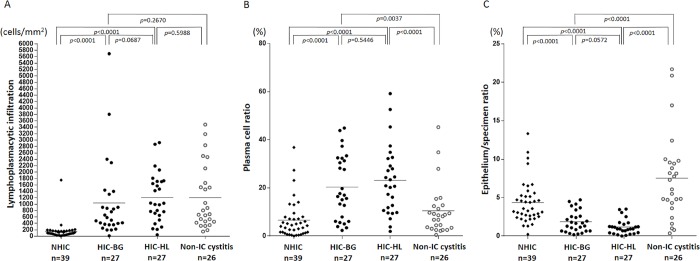
Evaluation of inflammatory cell infiltration and residual epithelium by image analysis software.(A) Lymphoplasmacytic infiltration in non-Hunner-type interstitial cystitis (NHIC), HIC-BG (background mucosa), HIC-HL (Hunner lesion) and non-IC cystitis specimens. Lateral bars indicate the means. Lymphoplasmacytic infiltration was much more severe in HIC-BG and HIC-HL than NHIC. The number of infiltrating mononuclear cells in NHIC specimens was very few (<200 cells/mm2) in most cases. The non-IC cystitis group showed a similar degree of mononuclear cell inflammation to that of HIC-BG and HIC-HL. (B) Plasma cell ratio in NHIC, HIC-BG, HIC-HL and non-IC cystitis specimens. This was significantly higher in HIC-HL and HIC-BG than in NHIC and non-IC cystitis. (C) Epithelium/specimen ratio in NHIC, HIC-BG, HIC-HL and non-IC cystitis specimens. Lateral bars indicate the means. The epithelium/specimen ratio is significantly lower in HIC specimens compared with NHIC and non-IC cystitis specimens (P <0.0001).